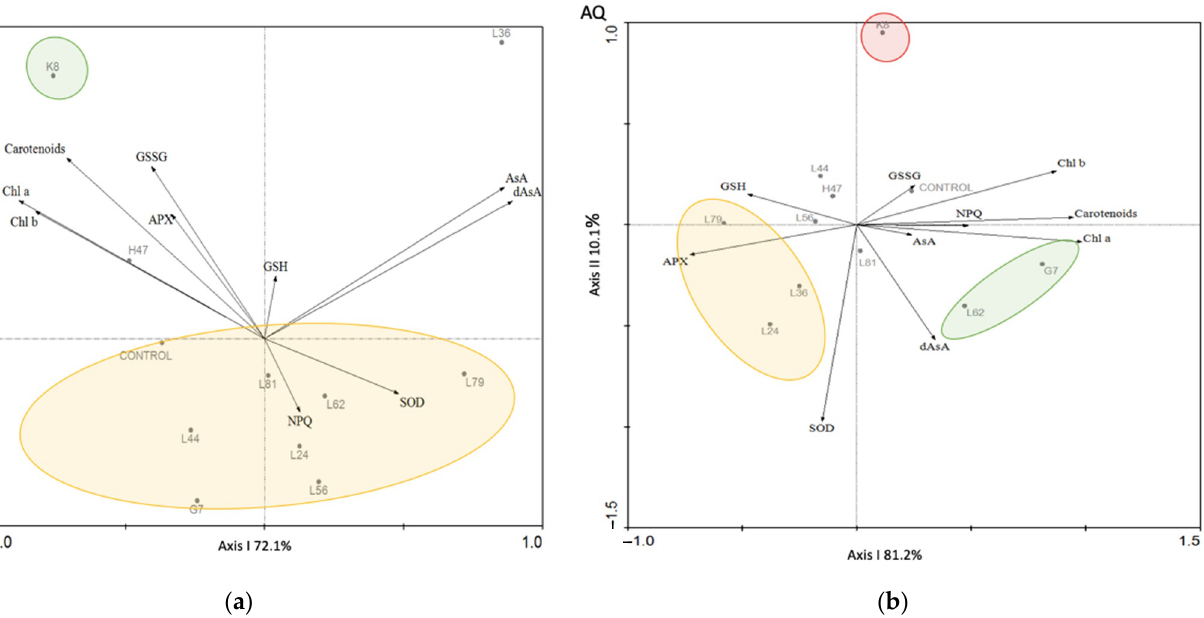
Figure 10. Principal component analysis (PCA) performed with data from physiological, metabolic and oxidative stress markers from ( a ) AS and ( b ) AQ inoculated with the 10 PGPB (G7, H47, K8, L24, L36, L44, L56, L62, L79, L81), and non-inoculated controls (CONTROL). Chl a, Chlorophyll a; Chl b, Chlorophyll b; Carotenoids; SOD, Superoxide Dismutase; APX, Ascorbate Peroxidase; GSH, reduced Glutathione; GSSG, oxidized Glutathione; AsA, reduced Ascorbic; dAsA, oxidized ascorbic acid; NPQ, non- photochemical quenching. Varianze absorbed by each axis is represented on the